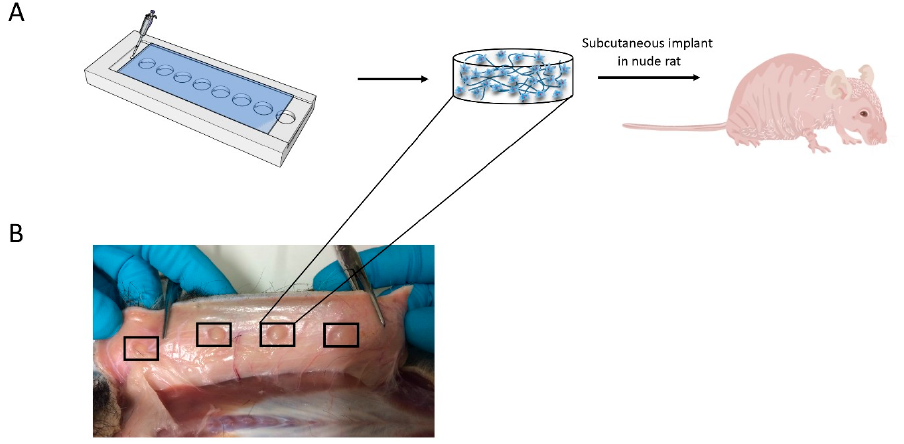
Figure 1. Experimental setup. ( A ) Schematic illustration of the outline of the experiment. Identical cell-laden hydrogels containing different types of cells were formed using a PTFE mold. Next, the prepared hydrogel constructs were implanted subcutaneously in the backs of 10 nude rats for 28 days. ( B ) Macroscopic observation of the different groups 28 days post-implantation. From left to right are representative pictures of groups HA-TA and co-culture, Dex-TA and bCHs, HA-TA/Dex-TA and hMSCs, and HA-TA/Dex-TA and bCHs, respectively. Frames denote the location of the implanted hydrogels.